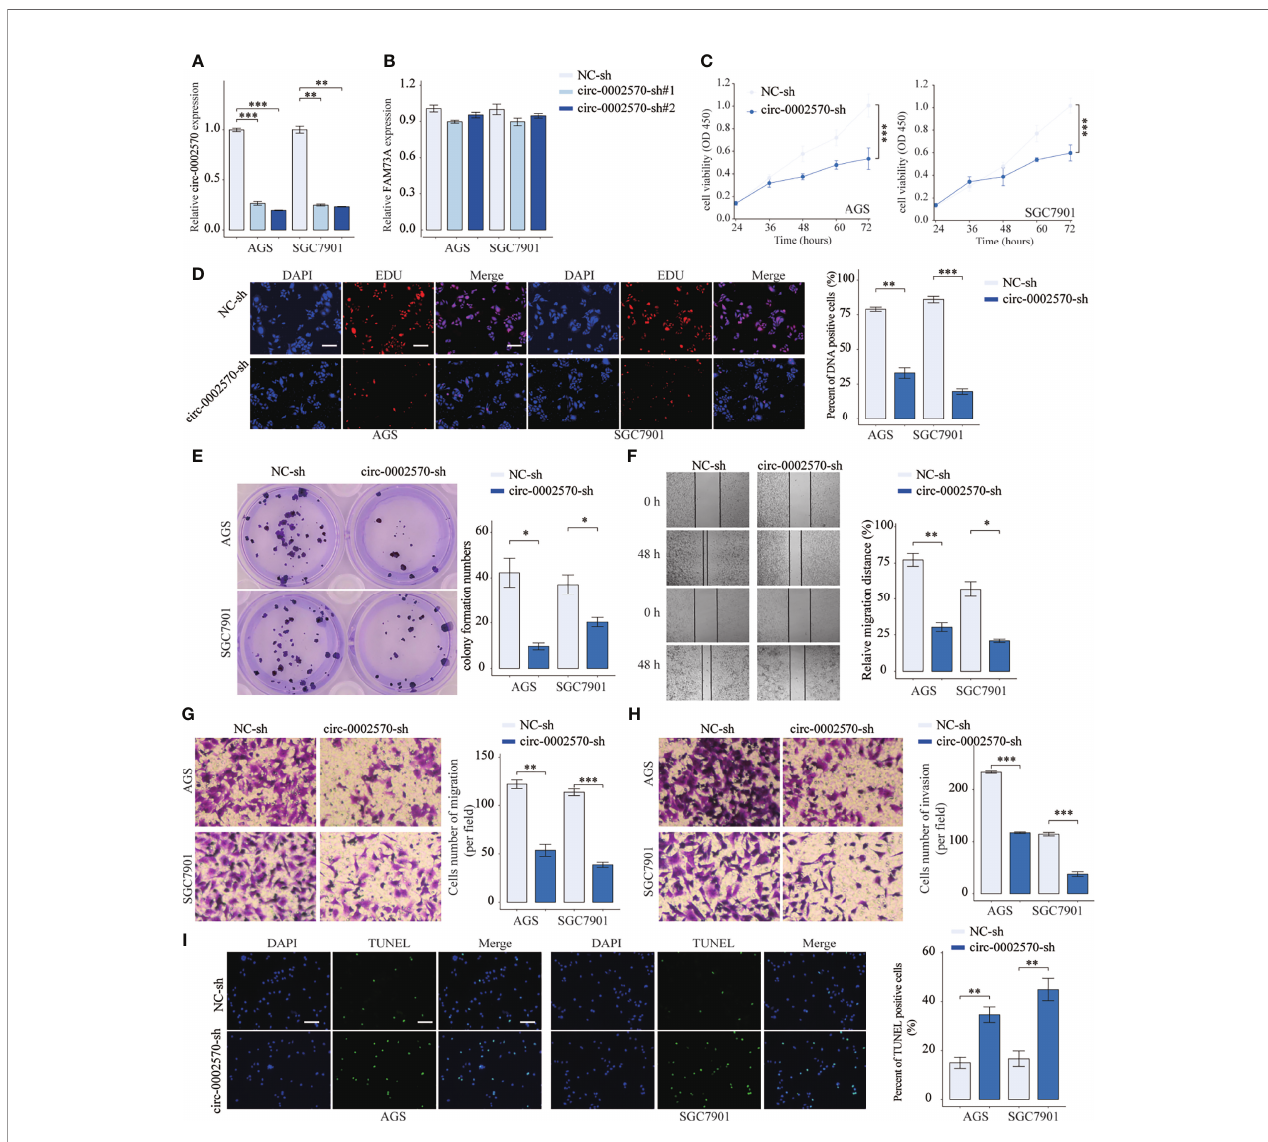
FIGURE 3 | The oncogenic roles of circ-0002570 in the progression of GC cells. (A, B) RT-PCR determined the expression of circ-0002570 and FAM73A in AGS and SGC7901 cells transfected with NC-sh, circ-0002570-sh#1, or circ-0002570-sh#2. (C) CCK-8 assay presented the proliferation of AGS and SGC7901 cells transfected with NC-sh or circ-0002570-sh. (D) Edu assays determined the proliferative ability. (E) Colony formation assay in AGS and SGC7901 cells after circ- 0002570 knockdown. (F) Migration of AGS and SGC7901 cells in different transfection groups was detected by scratch wound assays. (G, H) The migrative and invasive capacity of NC-sh or circ-0002570-sh transfected AGS and SGC7901 cells was assessed by transwell assays. (I) TUNEL was employed to analyze the apoptotic index. * p < 0.05, ** p < 0.01, *** p <